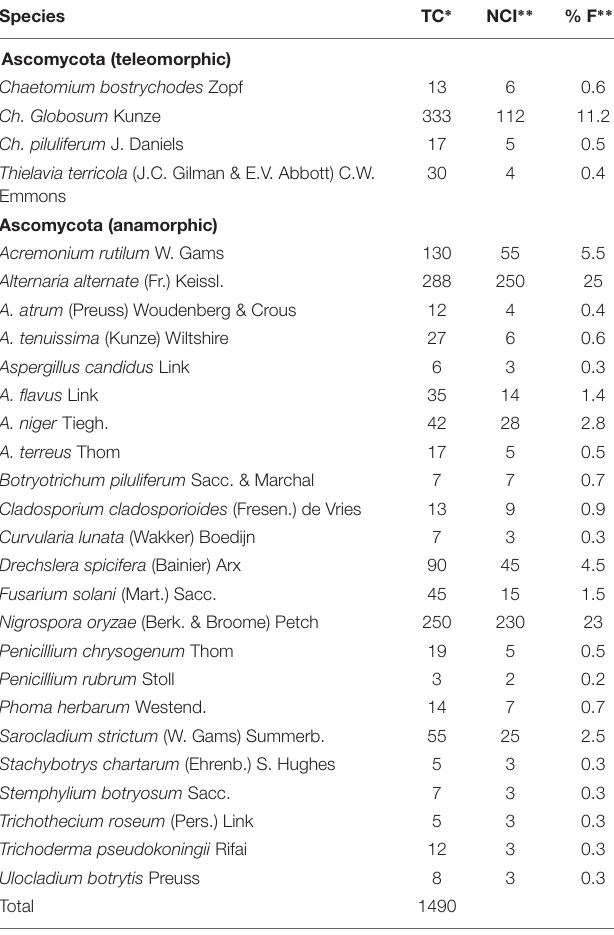
TABLE 1 | Total count, number of cases of isolation, and frequency of fungal taxa